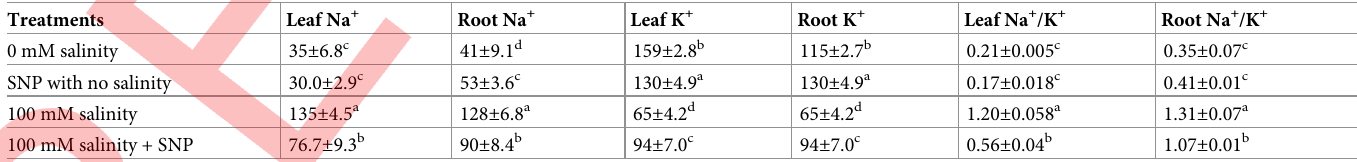
Table 1. Effect of different salinity and exogenous SNP application treatments on Na + (ppm) and K + (ppm) accumulation and Na + /Ka + ratio. Treatments Leaf Na